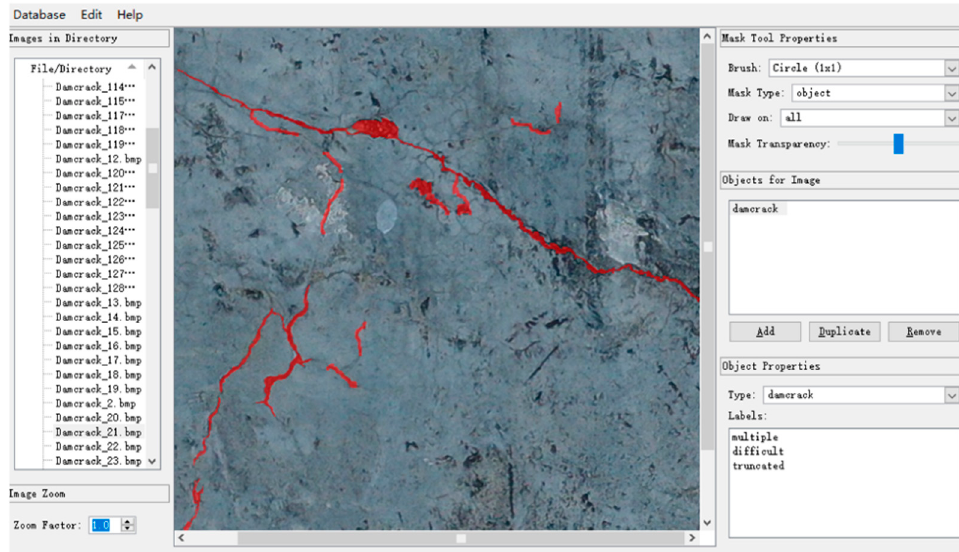
Figure 7. Labeling crack pixels using LEAR software.